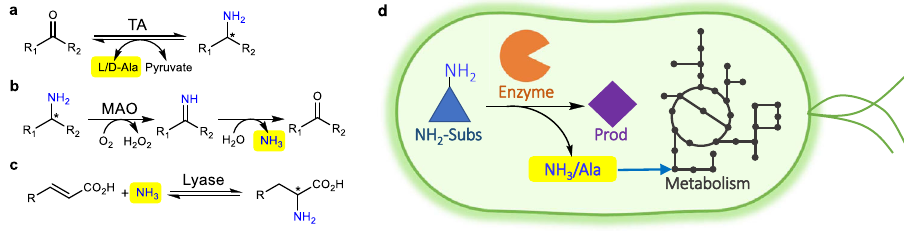
Fig. 1 | Concept of the growth selection system for the directed evolution of transaminases(TAs),monoamineoxidases(MAOs),andammonialyases.a The TA catalyzes the reversible transamination of a targeted amine and releases easily usable ʟ - or D -alanine (highlighted). b The MAO catalyzes oxidation of a targeted amine to its imine which is auto-hydrolyzed to release ammonia